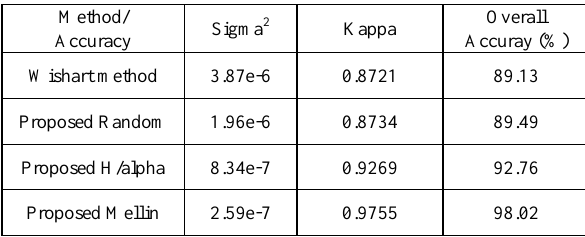
Table 1. Quantitative comparison of the results.